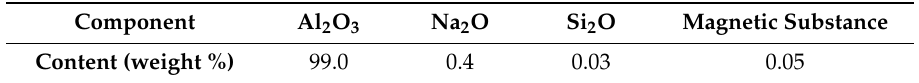
Table 1. Chemical composition of microcrystalline corundum.